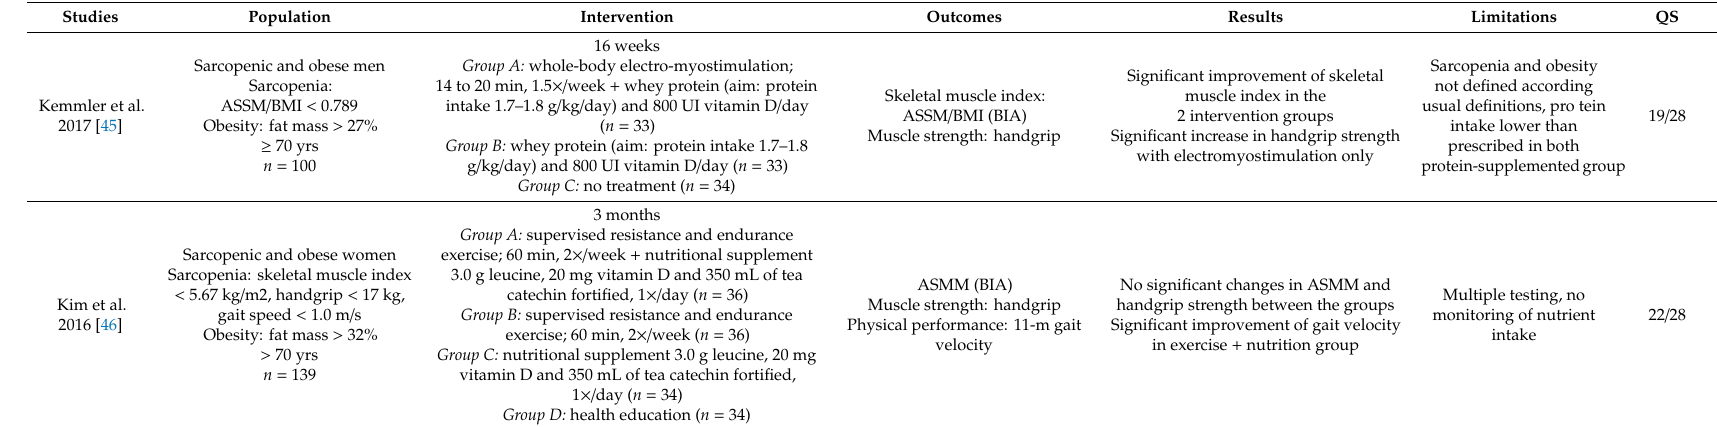
Skeletal muscle index: ASSM / BMI (BIA) Muscle strength: handgrip